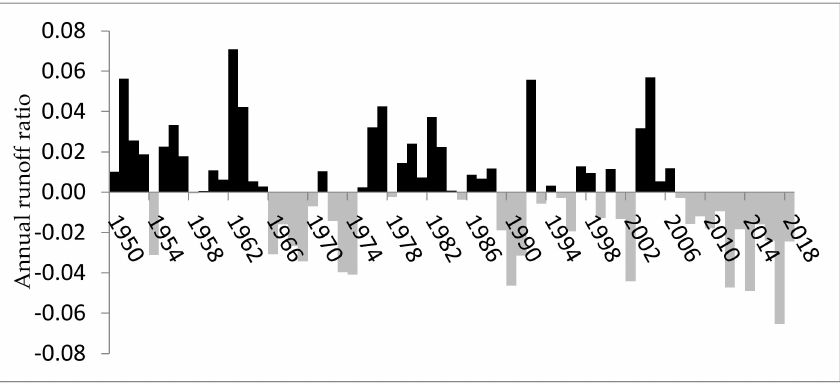
Figure 8. Deviation of annual runoff ratio (runoff/precipitation) from long term mean value